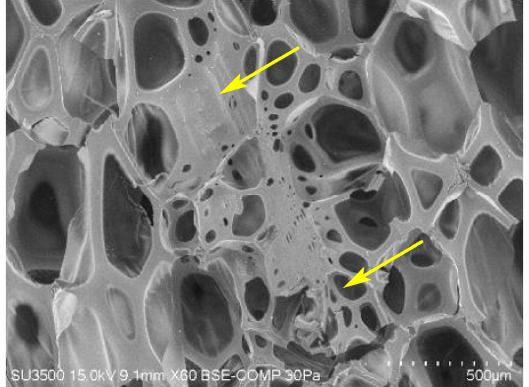
Figure 4. SEM images of PUR foam with addition of wood filler (arrows indicate changes in PUR structure in the presence of wood filler).